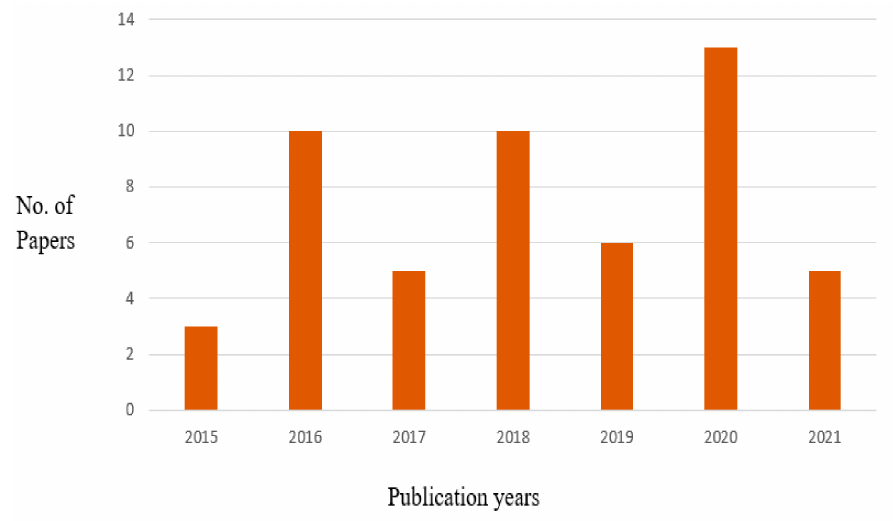
Figure 4. Publication year